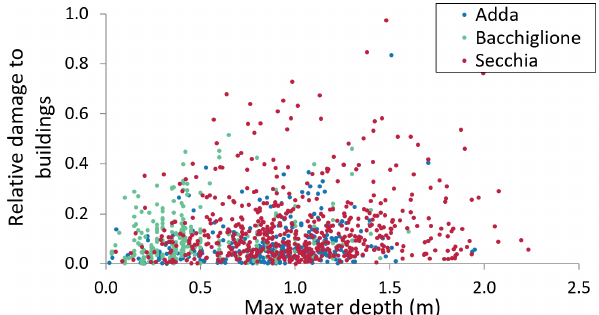
Figure 7. Scatter plot of relative damage ( y axis) in relation to max- imum observed water depth ( x axis). Records from the same event are shown with the same colour.